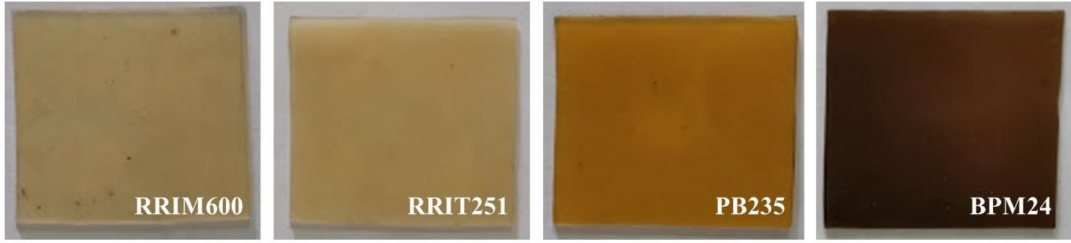
Figure 1. The color of the fresh natural latex from four different Hevea brasiliensis